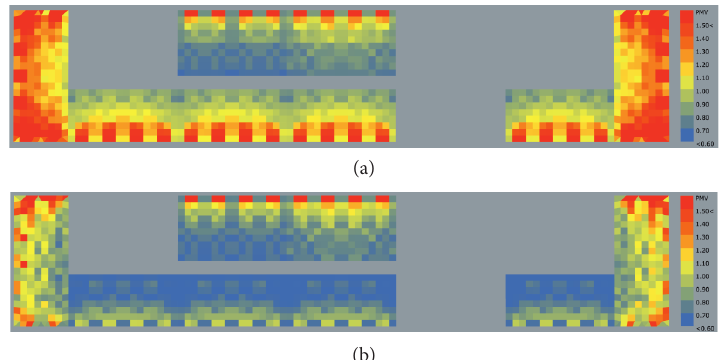
Figure 13: Visualization of PMV in the 7th floor office area before and after optimization. (a) PMV of initial solution and (b) PMV of Option